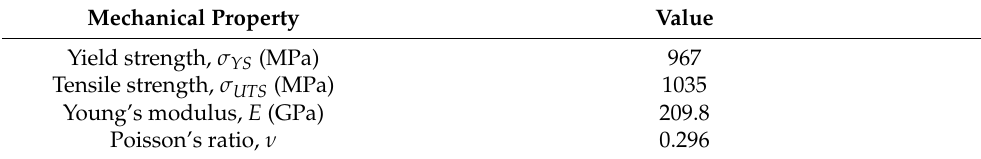
Table 2. Mechanical properties of the 34CrNiMo6 high-strength steel